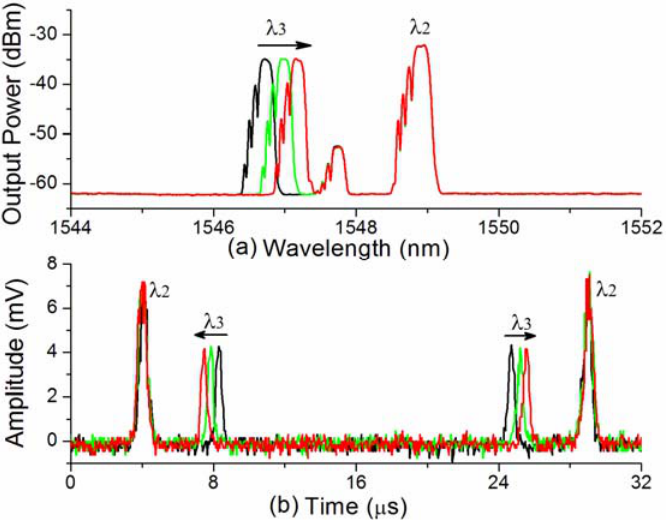
Figure 9. ( a ) Experimentally measured optical spectrum and ( b ) time-domain spectrum of the SL-FDML fiber laser when FBG3 is under strain tuning.